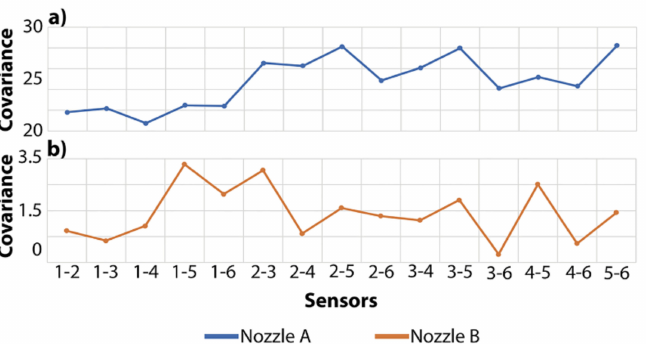
Figure 10. Covariances of bath level fluctuations. ( a ) Nozzle A without clogging. ( b ) Nozzle B without clogging.